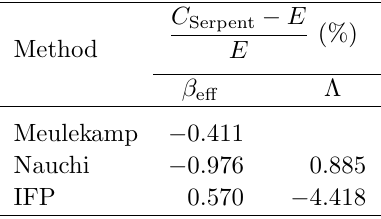
Table 4. Relative difference in Serpent-evaluated kinetics